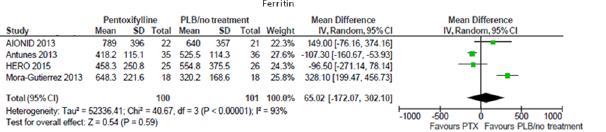
Fig 5. Effects of pentoxifylline vs. placebo/standard treatment on ferritin.